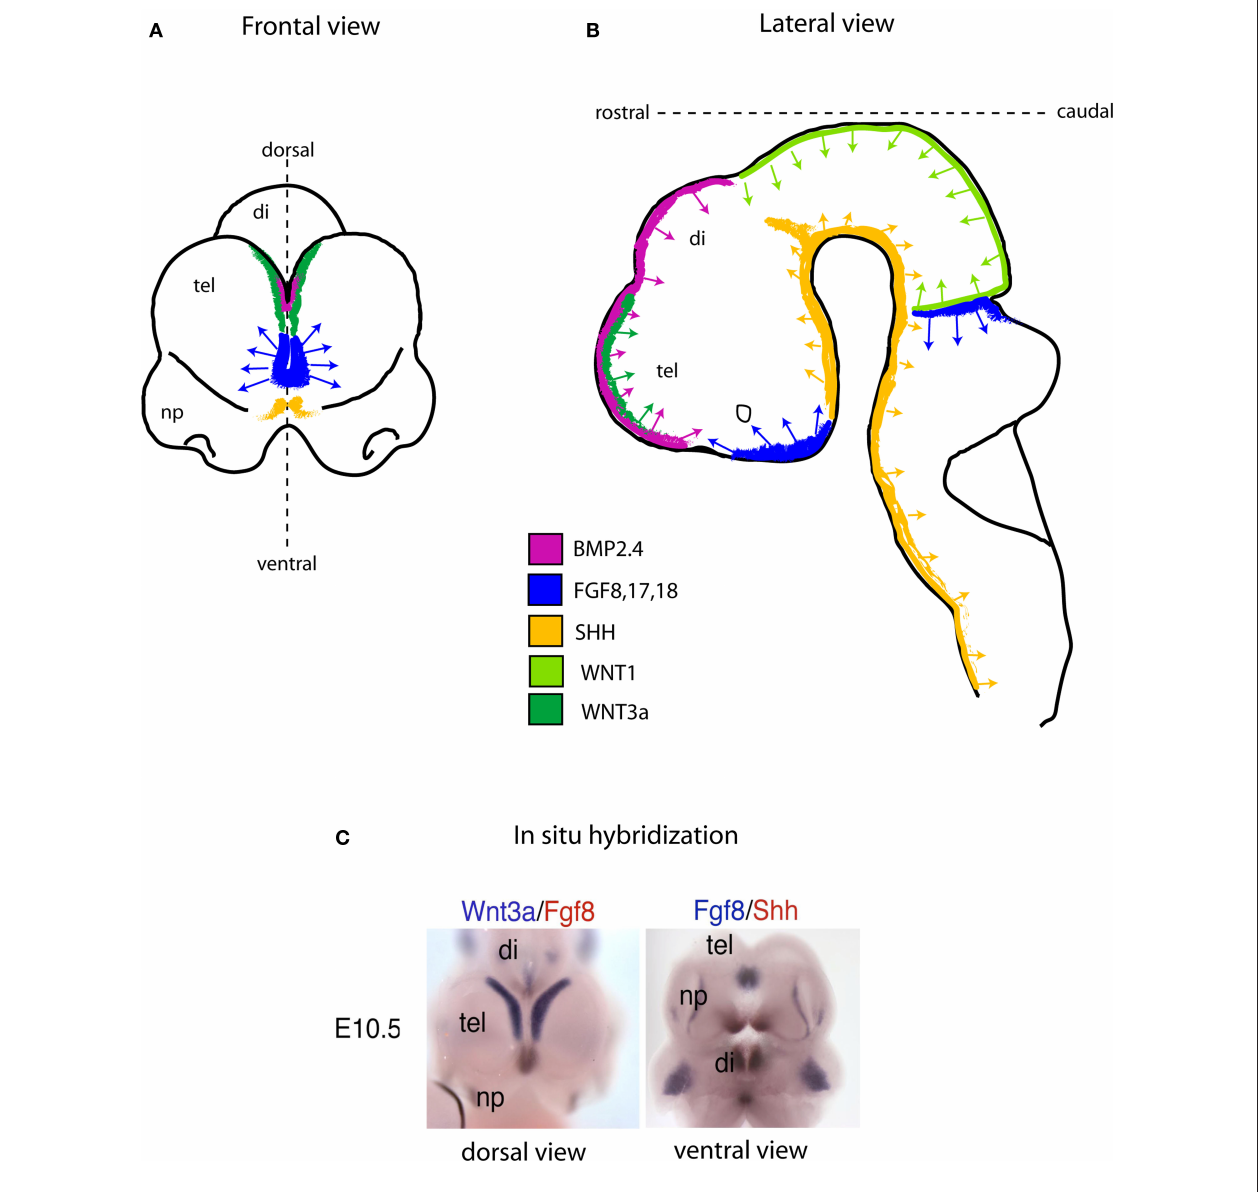
Figure 2 | Schematic showing the location of embryonic signaling centers at embryonic day (e) 10.5 in the mouse brain. The four families of secreted signaling molecules are positioned mainly at and near the midline region. In the telencephalon (Frontal view; A ) the most prominent source of Fgf activity is positioned between the cortical hem (green; a source of WNT and BMP), and